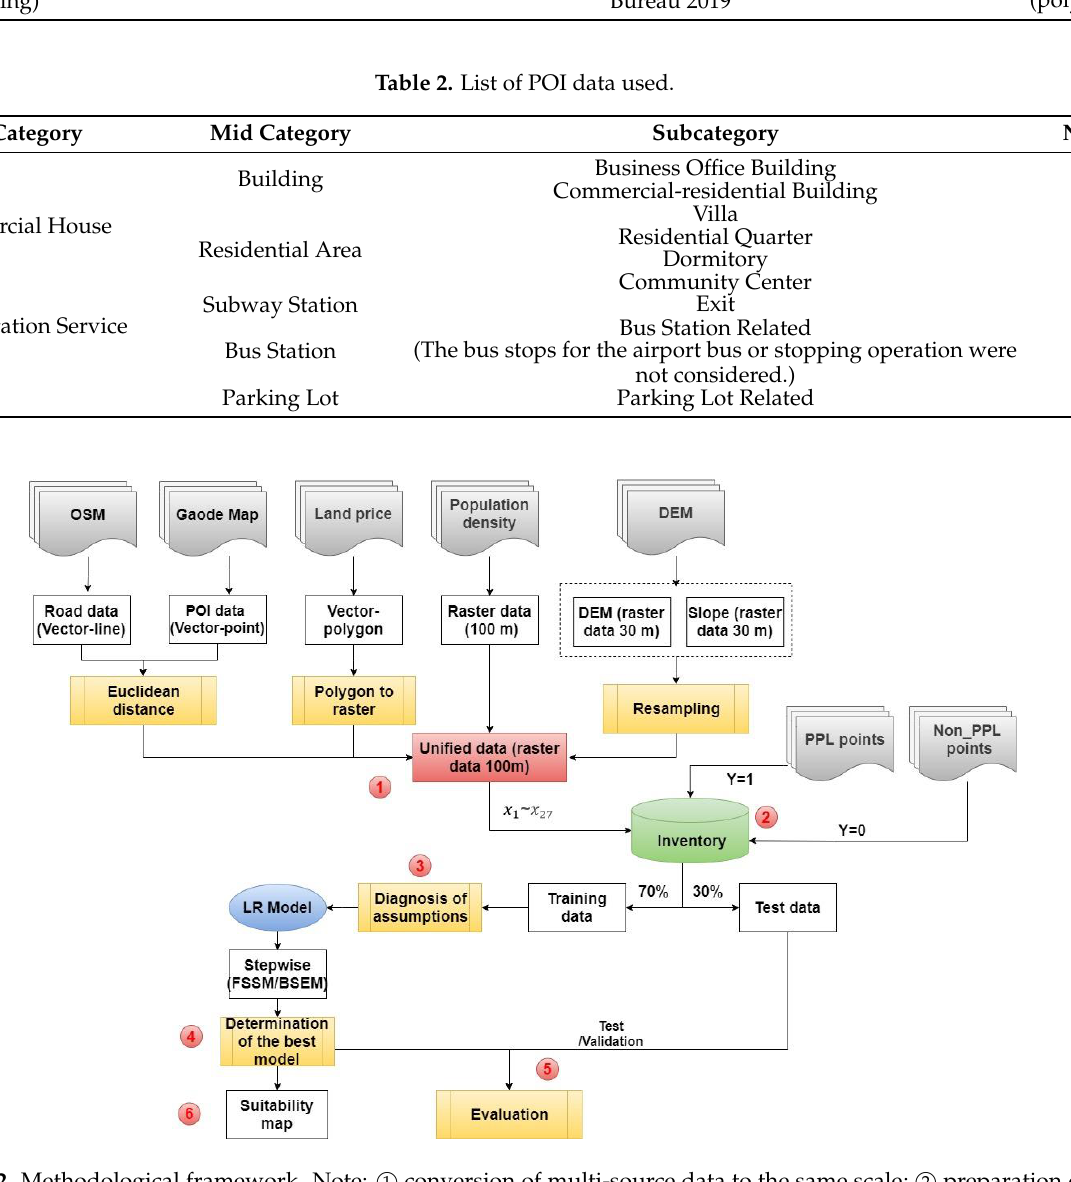
Figure 2. Methodological framework. Note: ① conversion of multi-source data to the same scale; ② preparation of the observation data; ③ diagnosis of the assumptions of LR model; ④ determination of the best model; ⑤ evaluation of the model performance; and ⑥ generation of the suitability map using the best model.